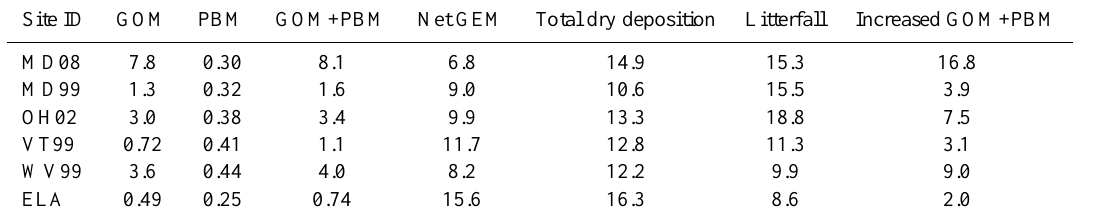
Table 2. Estimated speciated and total dry deposition (µgm − 2 yr − 1 ) and measured litterfall deposition (µgm − 2 yr − 1 ) at six sites. The last column represents upper-end estimation of GOM+PBM dry deposition by incorporating the potential uncertainties.